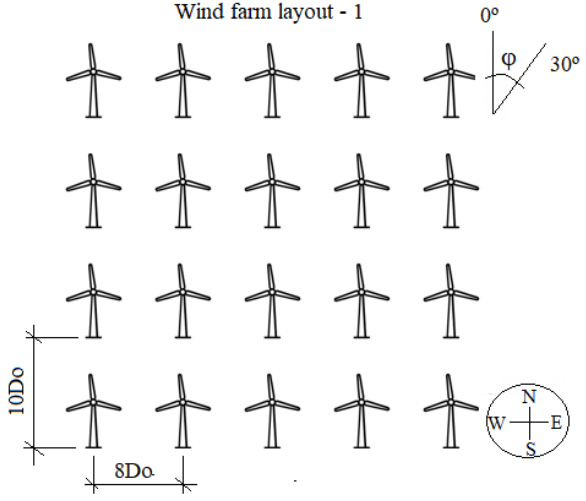
Figure 7. Optimal wind farm (layout 1) with the distance between turbines equal to 8D 0 , the distance between rows equal to 10D 0 , and wind direction angle equal to 30°.